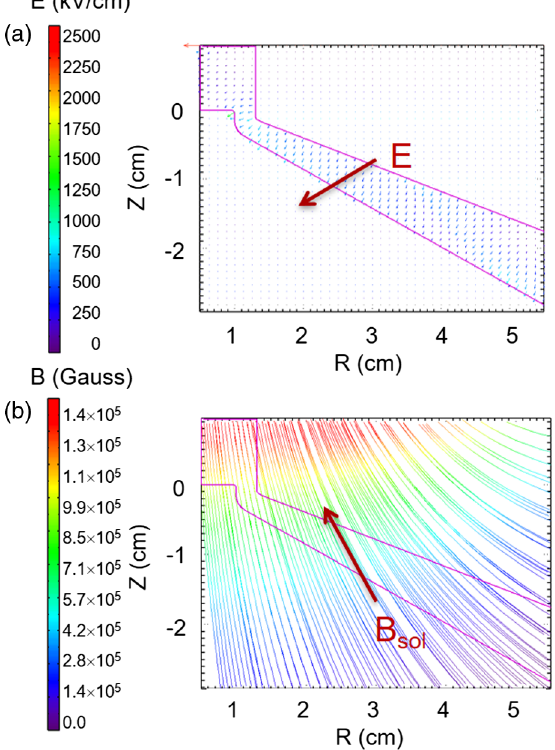
FIG. 10. The electric field vectors (a) and the applied magnetic field (b) at 25 ns in the Z pulse are plotted for the 17b inner MITL. The characteristic vectors across the gap are indicated by E and B in the plots. sol